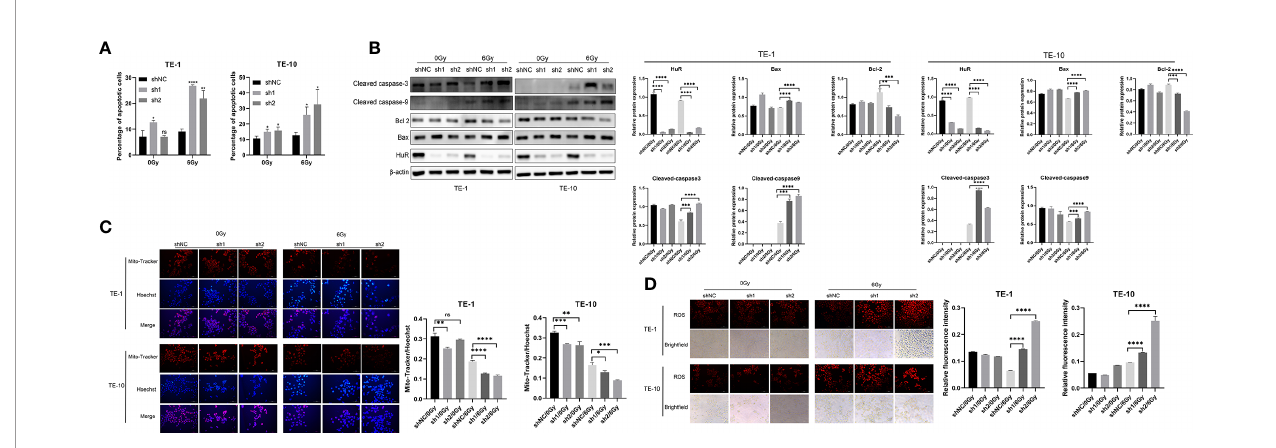
FIGURE 2 | Effect of HuR on X-ray irradiation, cell apoptosis and reactive oxygen species and mitochondrial membrane potential of esophageal cancer cells. (A) Flow cytometry detection of the effect of HuR on the cell apoptosis of esophageal cancer cells. The bar graph shows the proportion of apoptotic cells. HuR downregulation increases cancer cell apoptosis. (B) Expression of apoptosis-related proteins Bax, Caspase-3, Caspase-9, and Bcl-2 determined by Western blot. (C) Mitochondrial membrane potential of esophageal cancer cells determined by Mito-Tracker immuno fl uorescence. (D) Immuno fl uorescence detection of the effect of HuR on reactive oxygen